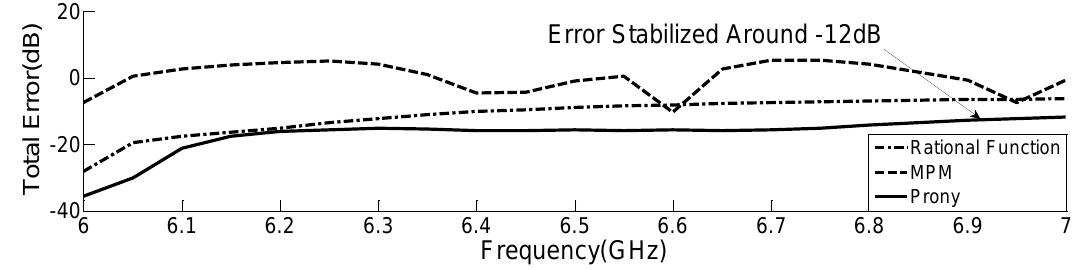
Figure 10. Transport Plane Prediction error results in all directions.